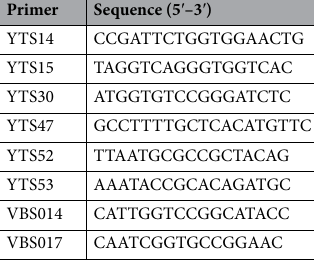
Primer Sequence (5 ′ –3 ′